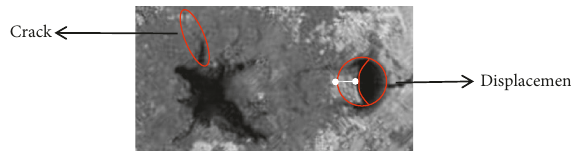
Figure 8: Deformation of coal inside control